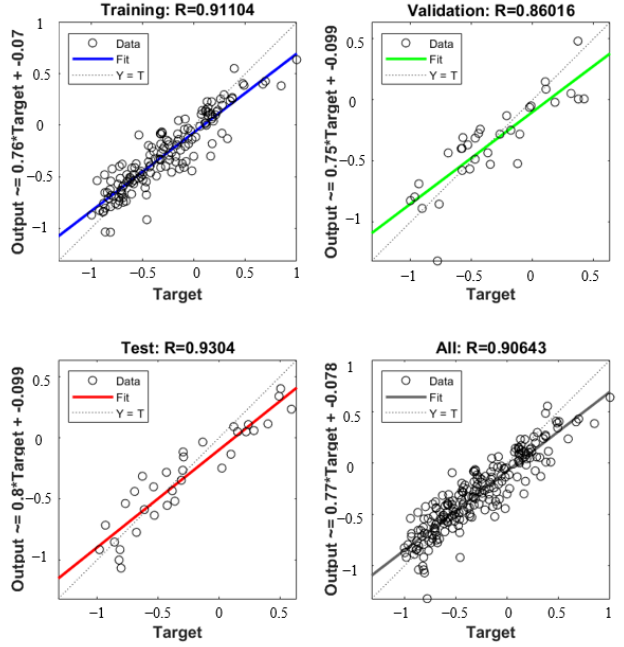
Figure 10. Correlation between training set and test set of PCA-BP neural network model.